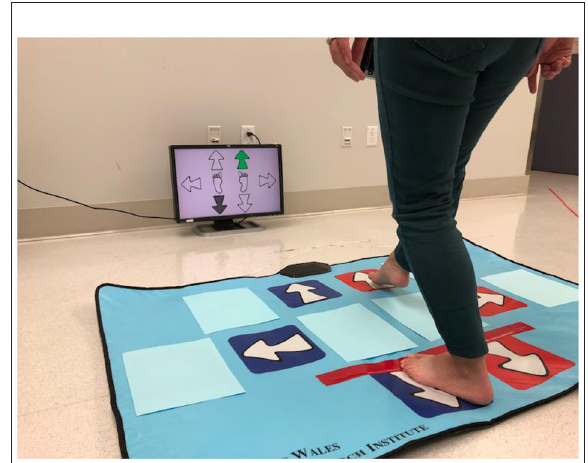
FIGURE1 An image of the instrumented step mat, with a person mid-step. Instructions provided to participants throughout the study included: At the start of Day 1 : Start with one foot on each of the arrows at the back of the mat, behind the red tape. That’s your START POSITION. When one of these arrows (POINT) turns green, step to the corresponding target on the mat as fast as you safely can, then return that foot to your start position. Next, one of the other arrows will turn green (POINT) , and you will step to that arrow’s corresponding target as fast as you safely can. Each time you make contact with a target, the arrow on the screen should change colors. If it does not change colors, that means you didn’t make sufficient contact with the target, so you must try again. Whenever you step, always use the foot that’s closest to the target, instead